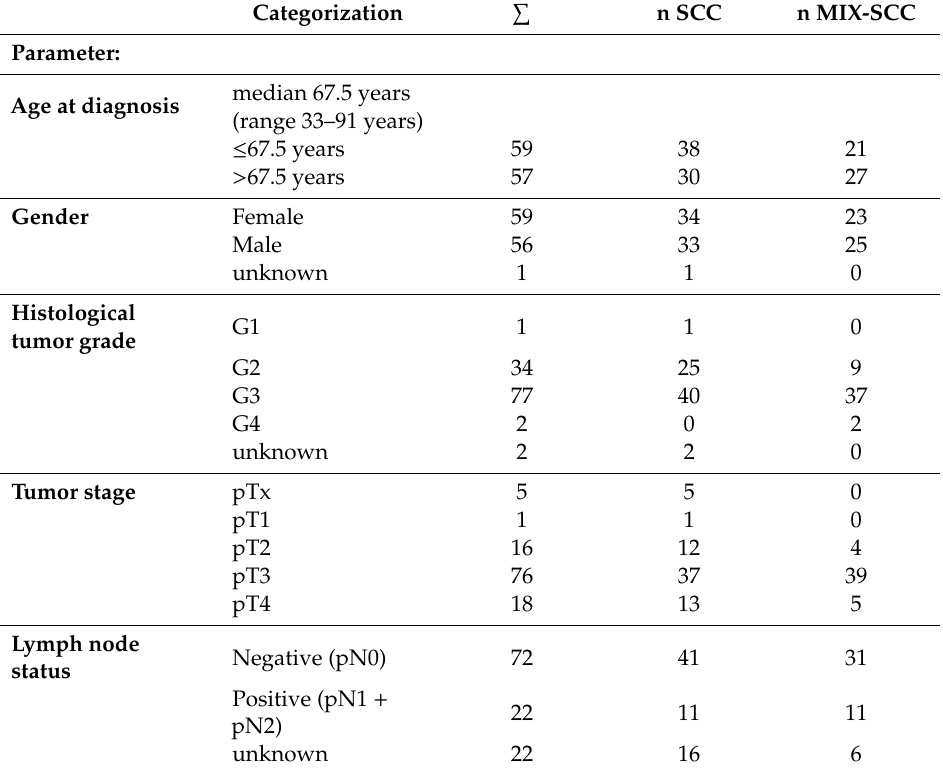
Table 1. Clinicopathological and demographical characteristics of the study